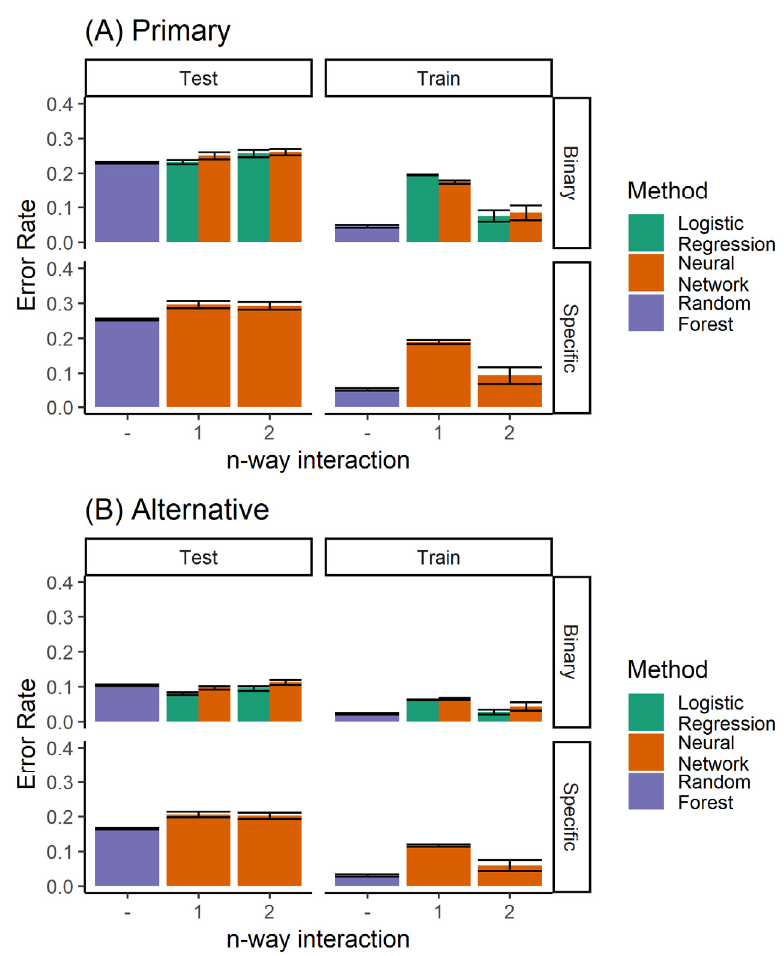
Figure 11. Performance of all the classifiers for predicting ( A ) the primary diagnosis, and ( B ) where agreement with either the primary or the alternative diagnoses is considered to be accurate. Here, both the single and ensemble (random forest) classifiers are included.